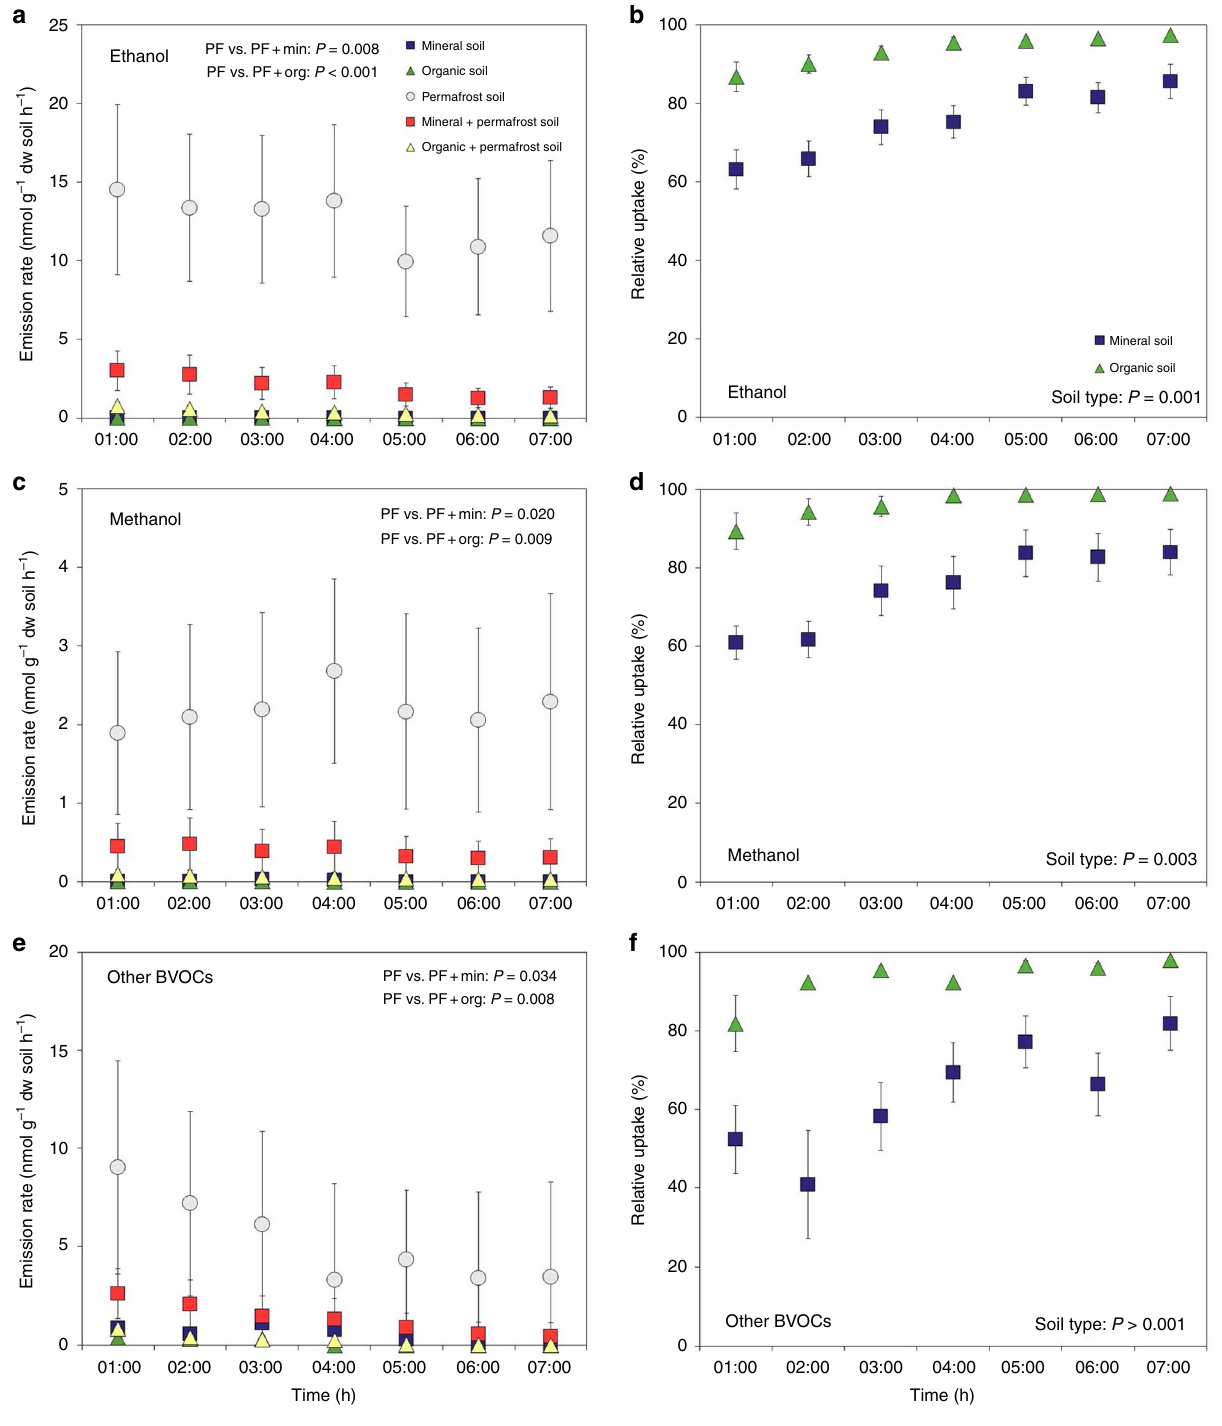
Fig. 3 Uptake of volatiles by mineral and organic active layer soils. Mean release rate ( n = 6) is shown for a ethanol, c methanol, and e other biogenic volatile organic compounds (BVOCs) from incubations of mineral soil, organic soil, permafrost soil, permafrost + mineral soil, and permafrost + organic soil. The relative uptake by mineral and organic active layer soils of b ethanol, d methanol, and f other BVOCs released by permafrost soils is furthermore presented. Statistically signi fi cant P values for the univariate analyses of variance (ANOVA) are shown. In a , c , e , P values from Dunnett ’ s test represent the difference in BVOC release between permafrost soil (PF) and permafrost + mineral soil (PF + Min) or permafrost + organic soil (PF + Org). In b , d , f , P values represent the effect of soil type on BVOC uptake. Error bars show standard error of the mean (5 ′ -CCTACGGGAGGCAGCAG-3 ′ ) and reverse primer 518 R (5 ′ -ATTACCGC BVOC release from thawing permafrost . For the BVOC measurements in GGCTGCTGG-3 ′ ) and 1µl DNA template, as previously described by Feld et al. 34 . the Release experiment, six 13-g fresh weight frozen permafrost soil samples were Soil characteristics in the active layer soils are presented in Supplementary placed in polyester woven mesh bags (mesh size 515 micron) and incubated in Table 1. 200 ml glass jars sealed by aluminium covered screw lids at 6°C for 43 h. The glass